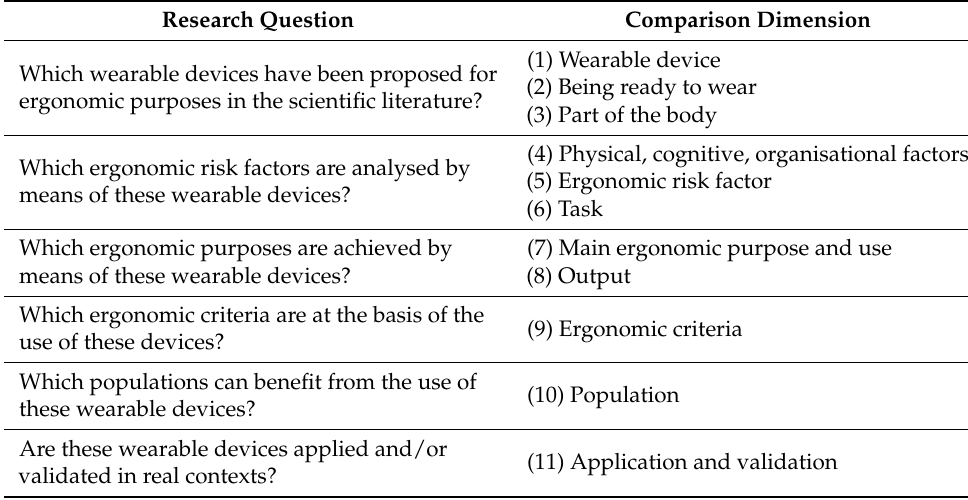
Table 2. Relationships between the research questions and comparison